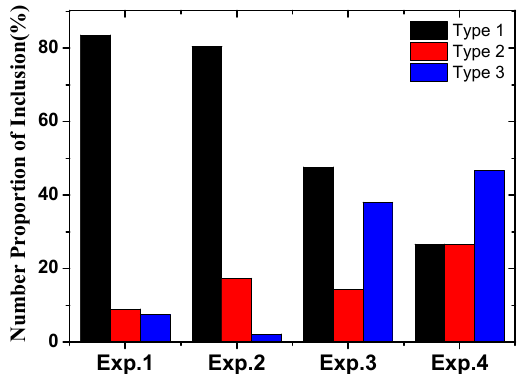
Figure 3. Proportion of three types of inclusions in each experiment.